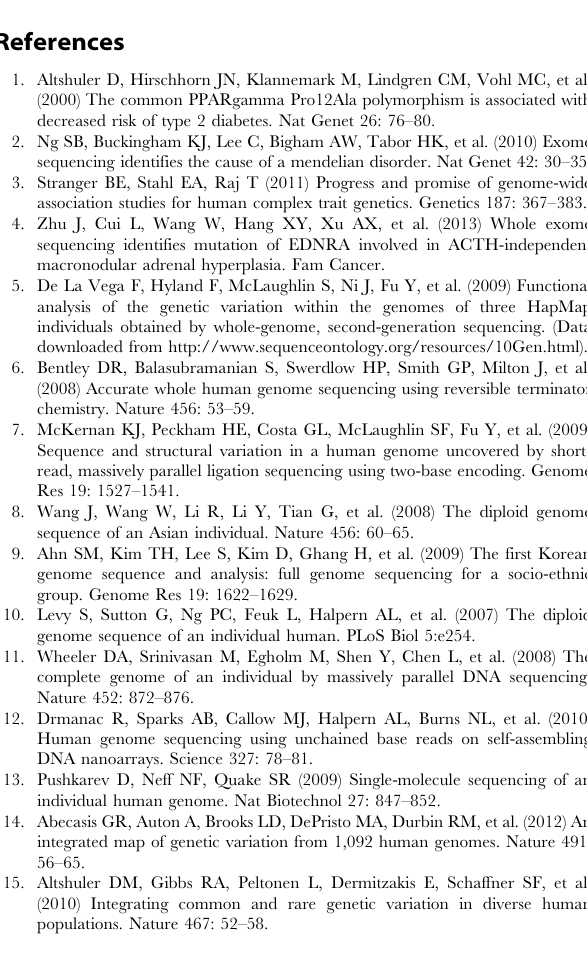
Table S5 List of the 164 deleterious variants that show significant differences in allele frequencies between KWS samples and continental populations. (PDF) Table S6 Alignment statistics and genome coverage for the KWS1 and KWS2 (whole genome) samples. For calculating the percentage of genome covered, the length of human genome is considered as 3,000,000,000 bps (for WGS) and 62,000,000 (for exomes). (GIF) Table S7 Concordance rates for SNP calls between deep sequencing experiments and genome-wide genotyping. (PDF) Table S8 Details about genome sequences used to compare diversity of KWS genomes. (PDF) Dataset S1 Data set of all identified exomic SNPs (known and novel) from the UE data set of the 15 samples. The data is presented in Variant Call Format (VCF). (GZ) Dataset S2 Data set of all identified exomic indels (known and novel) from the UE data set of the 15 samples. The data is presented in Variant Call Format (VCF). (GZ)